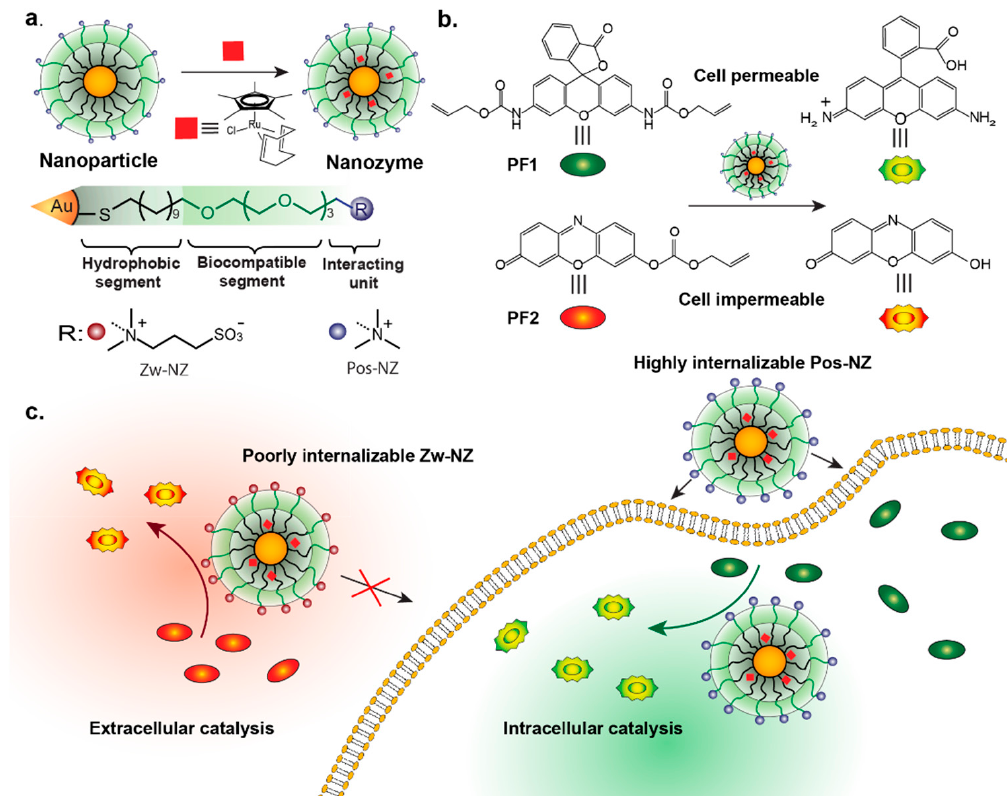
Figure 5. ( a ) Schematic representation of nanoparticles, nanozymes and ligand structures of zwitterionic nanozymes (Zw-NZ) and cationic nanozymes (Pos-NZ). ( b ) Structures of prodyes and their corresponding fluorescent products (rhodamine 110 and resorufin) after bond cleavage catalyzed by Ru-based complex in NZs. ( c ) Schematic representation of specific localization of nanozymes by engineering surface functionalities; activation of PF1 happens in intracellular region while that of PF2 occurs extracellularly. (Adapted with permission from Reference [75], Published by American Chemical Society, 2019).